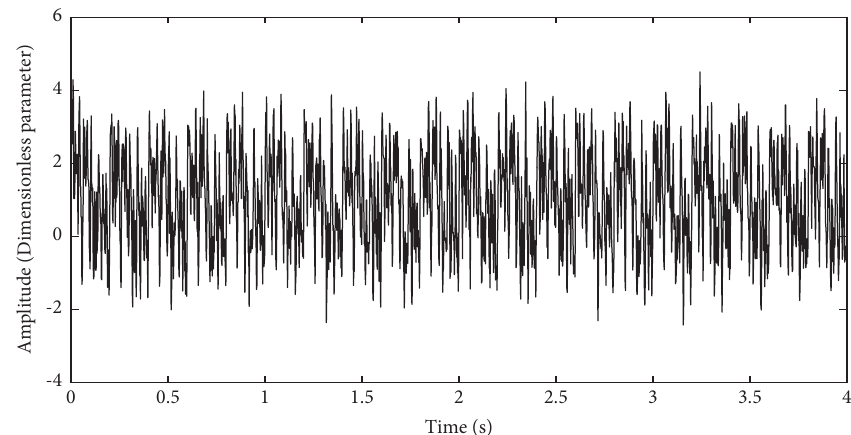
Figure 4: The waveform of the designated signal in time